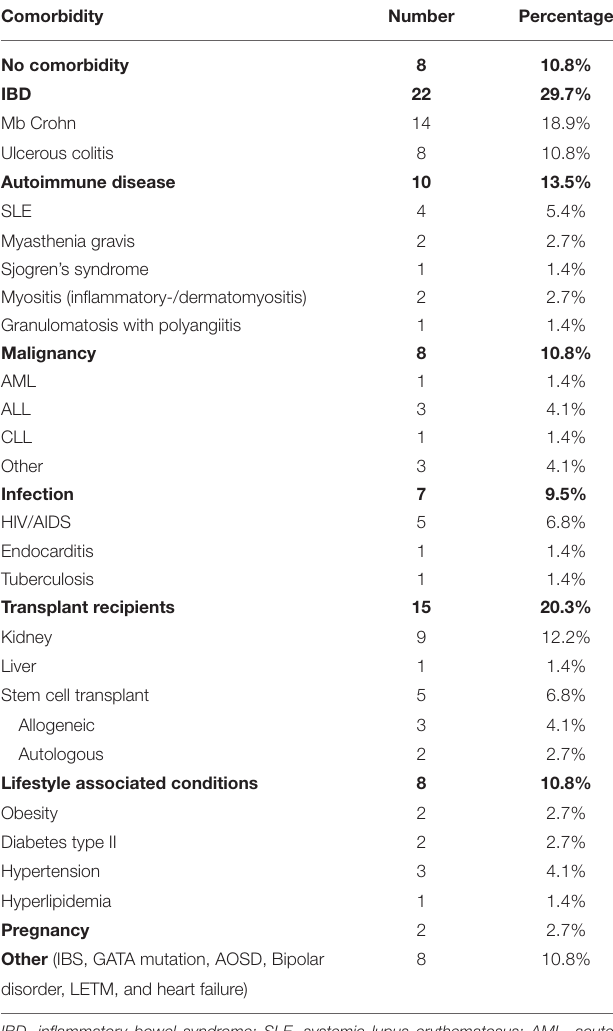
TABLE 4 | Comorbidity present in the patient group.